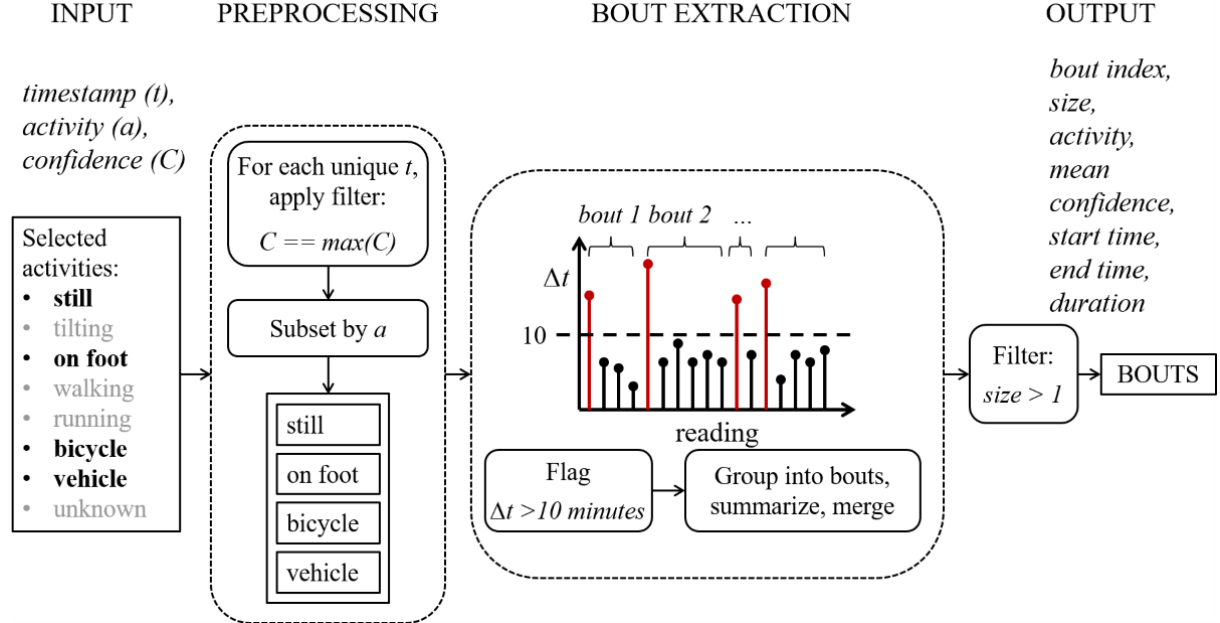
Figure 4. Bout extraction from activity